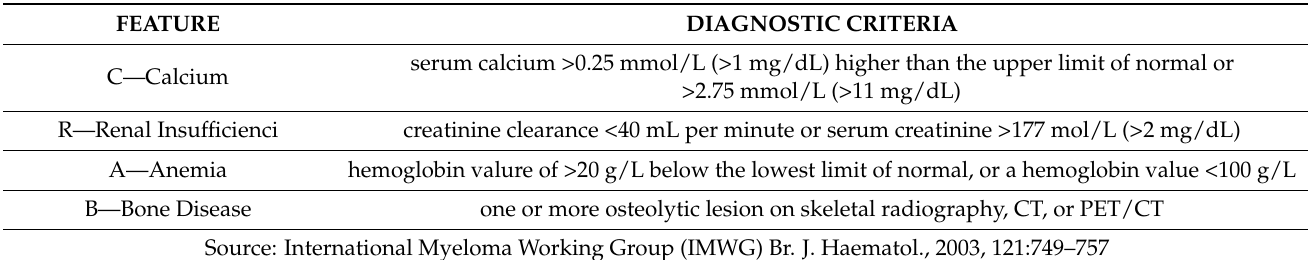
Table 1. The CRAB criteria used in the diagnosis of multiple myeloma